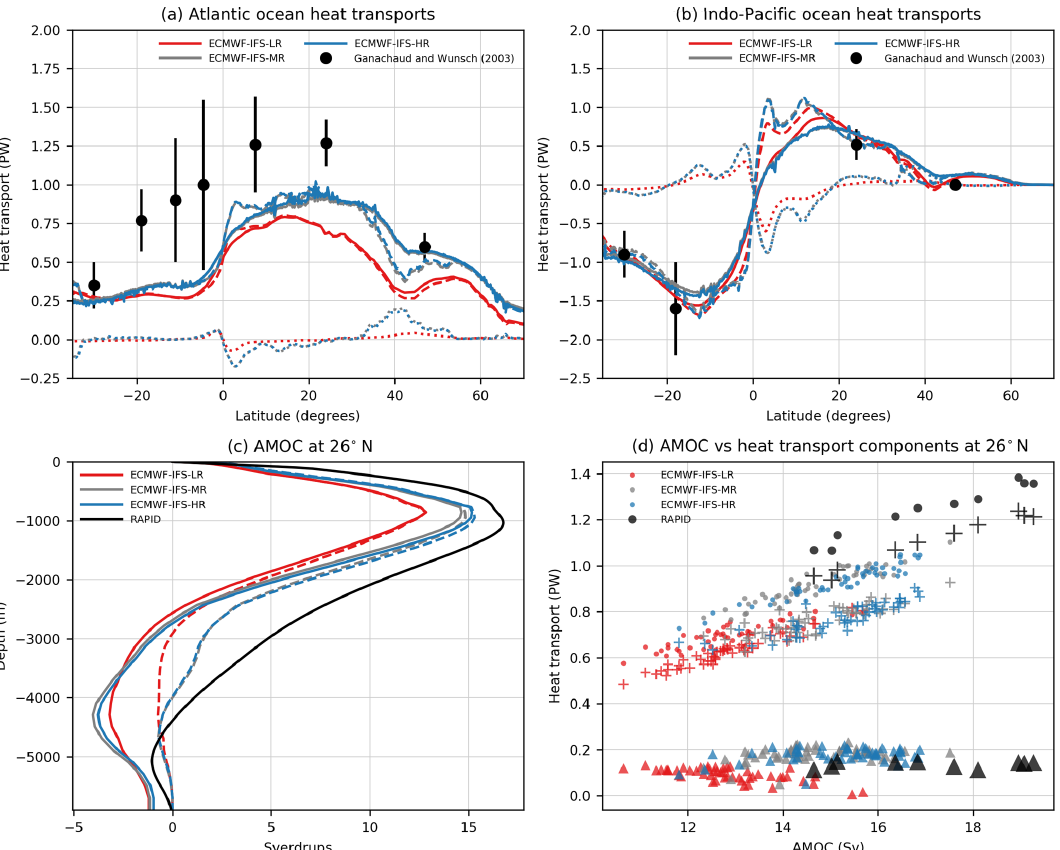
Figure 12. (a–b) Meridional ocean heat transport calculated using years 1–50 of the spinup-1950 experiment compared with the observational estimates from Ganachaud and Wunsch (2003). Total heat transport (solid lines) is decomposed into contributions from the mean flow ( V · T ; dashed lines) and time-varying “eddies” ( V (cid:48) · T (cid:48) ; dotted lines). (c) Stream functions of AMOC at 26.5 ◦ N calculated using years 1–50 of spinup-1950 compared to observations from RAPID-MOCHA array for the period 2004–2015 (McCarthy et al., 2015). Dashed lines correspond to model profiles calculated using the RapidMoc Python tool (Roberts, 2017) with a geostrophic reference depth of 4750m. (d) Strength of AMOC at 26.5 ◦ N against total (circles), overturning (plus signs), and horizontal gyre (triangles) components of the meridional heat transport in spinup-1950. Observed heat transport components are from the RAPID-MOCHA array (Johns et al., 2011), and symbols correspond to annual